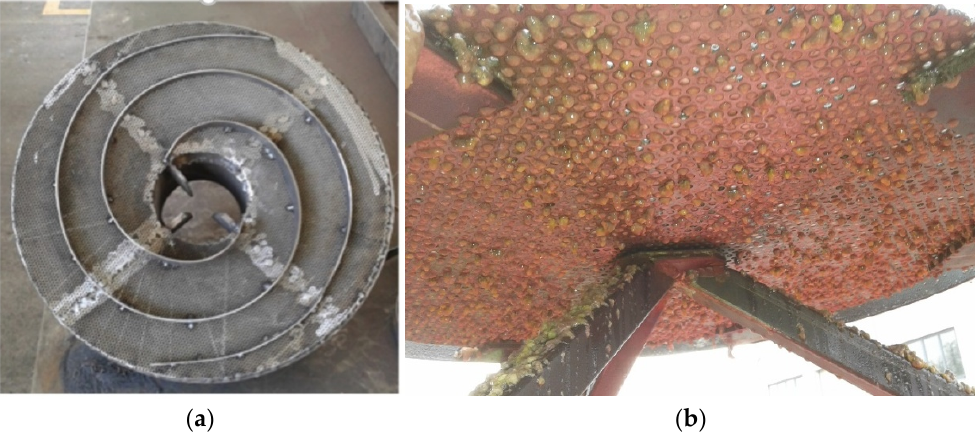
Figure 5. Third prototype realisation: ( a ) double spiral working chamber; ( b ) extrusion of pitted olive pulp.